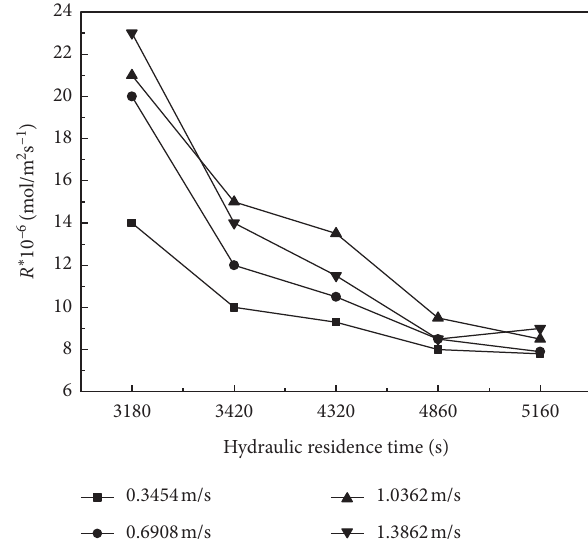
Figure 5: Effect of circulation flow rate on extraction rate.